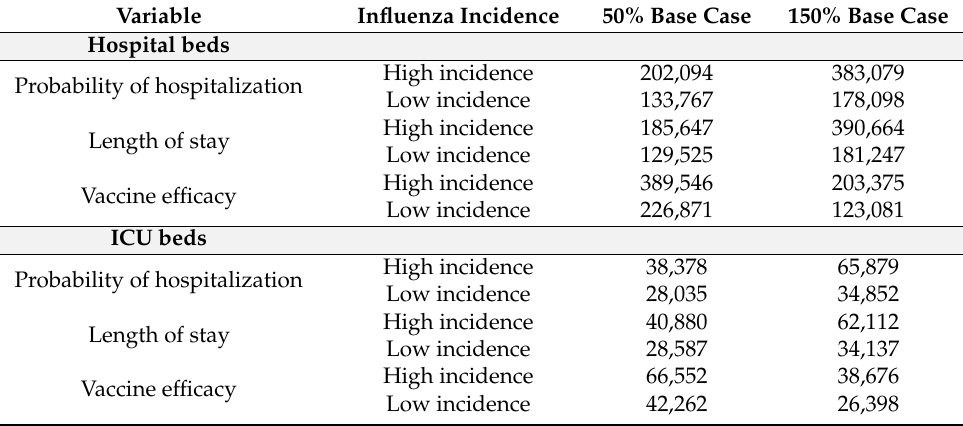
Table 2. Sensitivity analysis evaluating the effects of reducing the probability of hospitalization, length of stay, and vaccine efficacy. Each parameter was varied to be 50% and 150% of base case assumptions. The acute hospital and ICU bed occupancy for high and low incidence influenza seasons are shown. Analysis assumes use of QIVe across all age groups and a vaccine coverage rate of